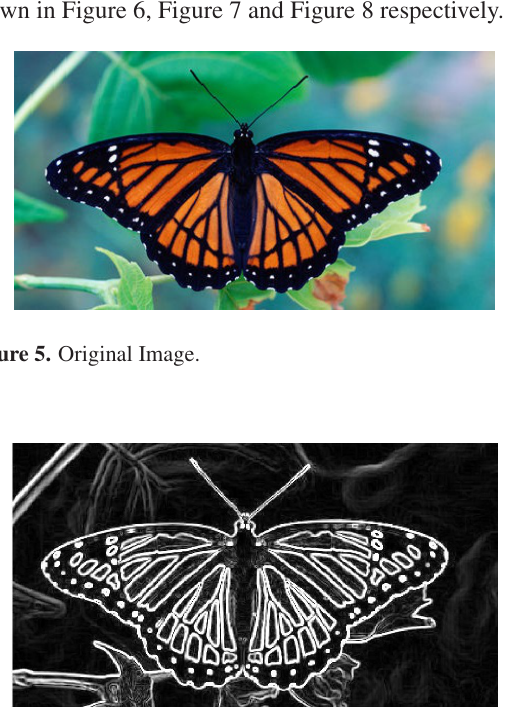
Figure 9. Interfacing of Nexys 4 DDR board with